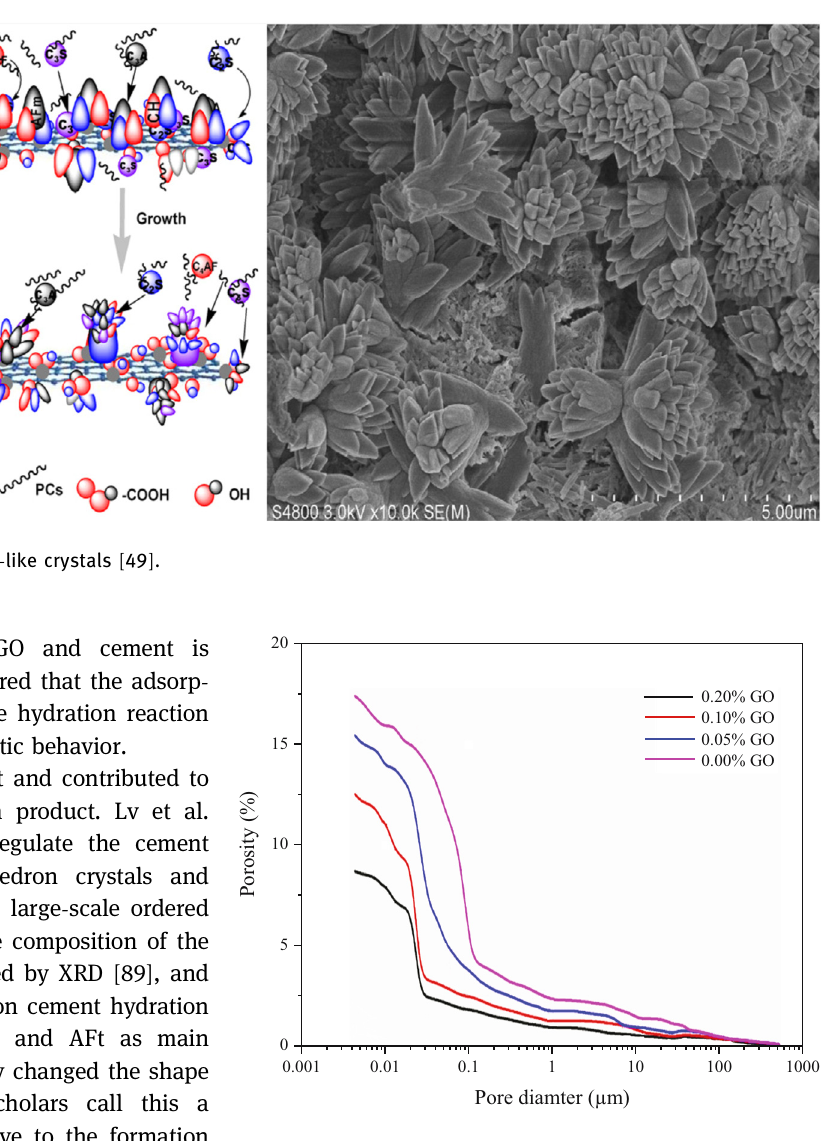
Figure 9: Mercury intrusion porosimetry test results of GO - modi fi ed cementitious materials [ 67 ]